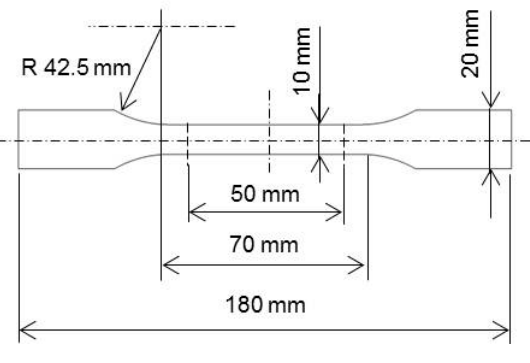
Figure 3. Uniaxial tensile specimen.